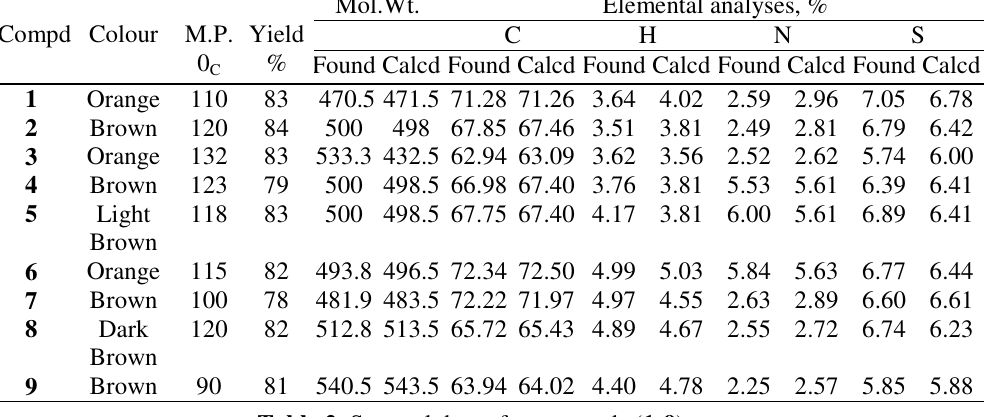
Table 2. Spectral data of compounds ( 1-9